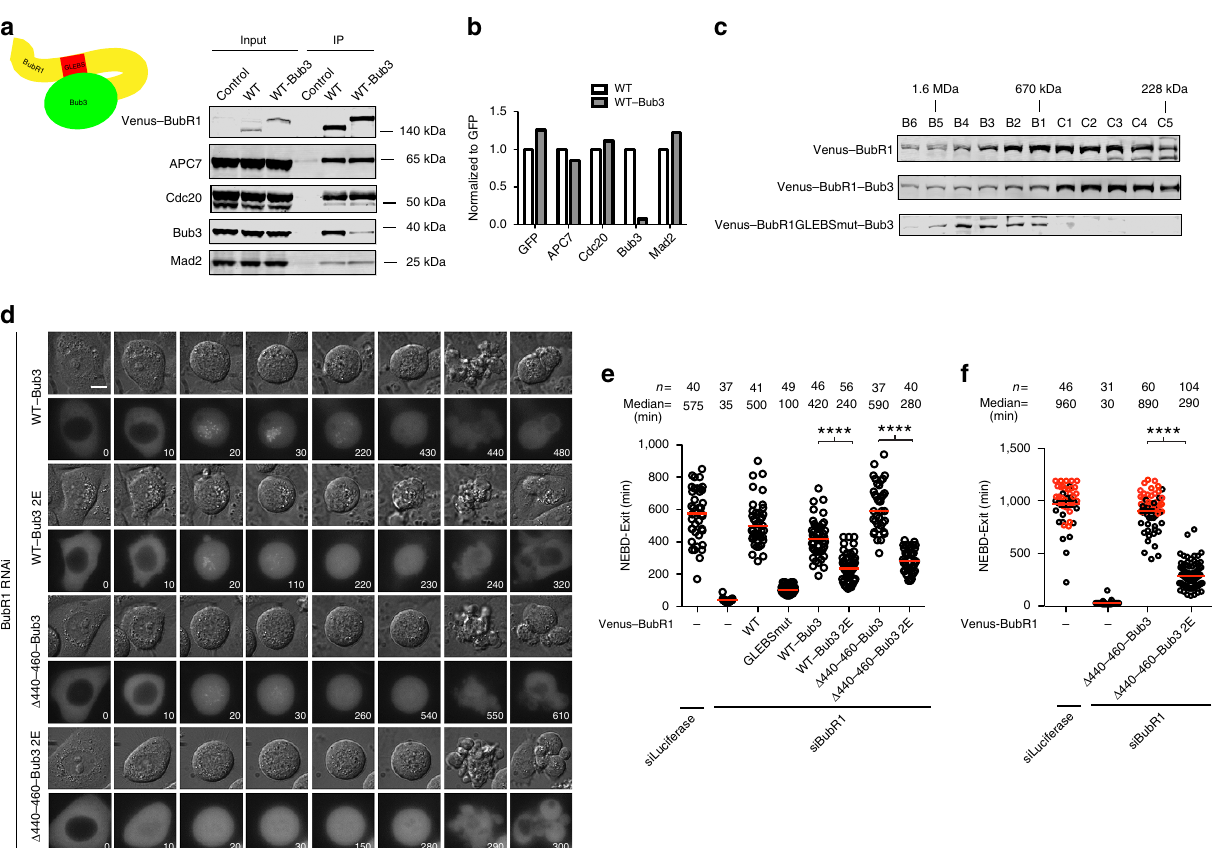
Figure 5 | Kinetochore localization of the Bub1-independent pool of BubR1/Bub3 stimulates checkpoint signalling. ( a ) Cartoon of the internal binding between Bub3 and GLEBS domain on BubR1 in the fusion protein BubR1–Bub3. Venus-tagged RNAi-resistant wild-type (WT) BubR1 or BubR1–Bub3 plasmid was transfected into HeLa cells together with RNAi oligos against BubR1 for 48h. After nocodazole treatment, mitotic cells were collected and lysed. Immunoprecipitation was performed against Venus tag by GFP-Trap beads. The presence of APC7, Bub3, Cdc20 and Mad2 was analysed by Li-cor quantitative western blot. ( b ) Western blot results in a were quantified and plotted. The values from BubR1 WTwere set to 1. ( c ) Venus-tagged BubR1 WT or BubR1–Bub3 or BubR1 GLEBSmut–Bub3 plasmid was transfected into HeLa cells for 48h. After nocodazole treatment, mitotic cells were collected and lysed and extract separated on a Superose-6 column and the relevant fractions analysed by western blot. Migration of molecular weight standards (670kDa) or calculated molecular weights based on a calibration curve is indicated on top. ( d ) HeLa cells were co-transfected with BubR1 RNAi oligos and Venus-tagged BubR1–Bub3, BubR1–Bub3 2E, BubR1 D 440–460–Bub3 or BubR1 D 440–460–Bub3 2E plasmid. Live-cell imaging was performed to record the time cells spent in mitosis in the presence of low-dose nocodazole. Representative still images are shown. Scale bar, 5 m m. ( e ) Quantification of the live-cell imaging results of d . ( f ) HeLa cells were co-transfected with BubR1 RNAi oligos and Venus-tagged BubR1 D 440–460–Bub3 or BubR1 D 440–460–Bub3 2E plasmid. Live-cell imaging was performed to record the time cells spent in mitosis in the presence of taxol. Quantification of the live-cell imaging results is shown. n indicates the total number of cells counted. The red line in the plot indicates median time cells spent in mitosis. A Mann–Whitney test was used for statistical comparison of the different samples. (**** P r 0.0001). Note: the red dots in f represent the cells still arrested in mitosis when filming